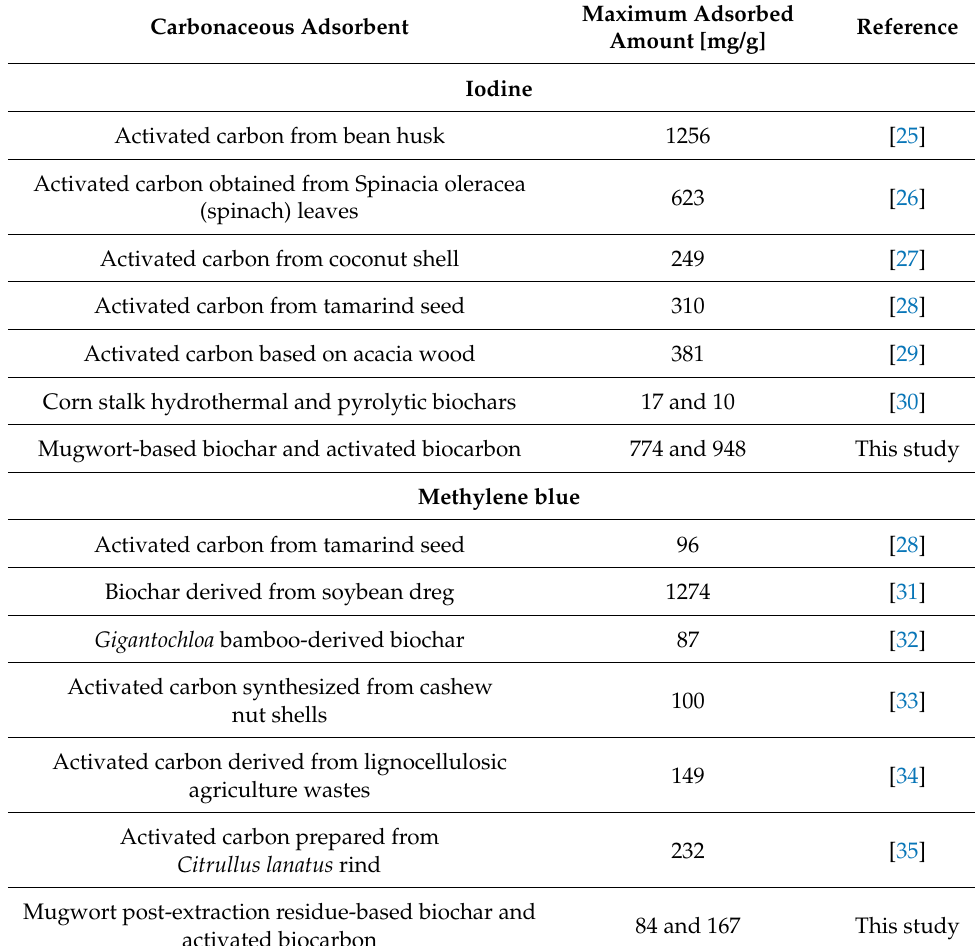
Table 6. Adsorption capacities towards iodine and methylene blue for various carbonaceous